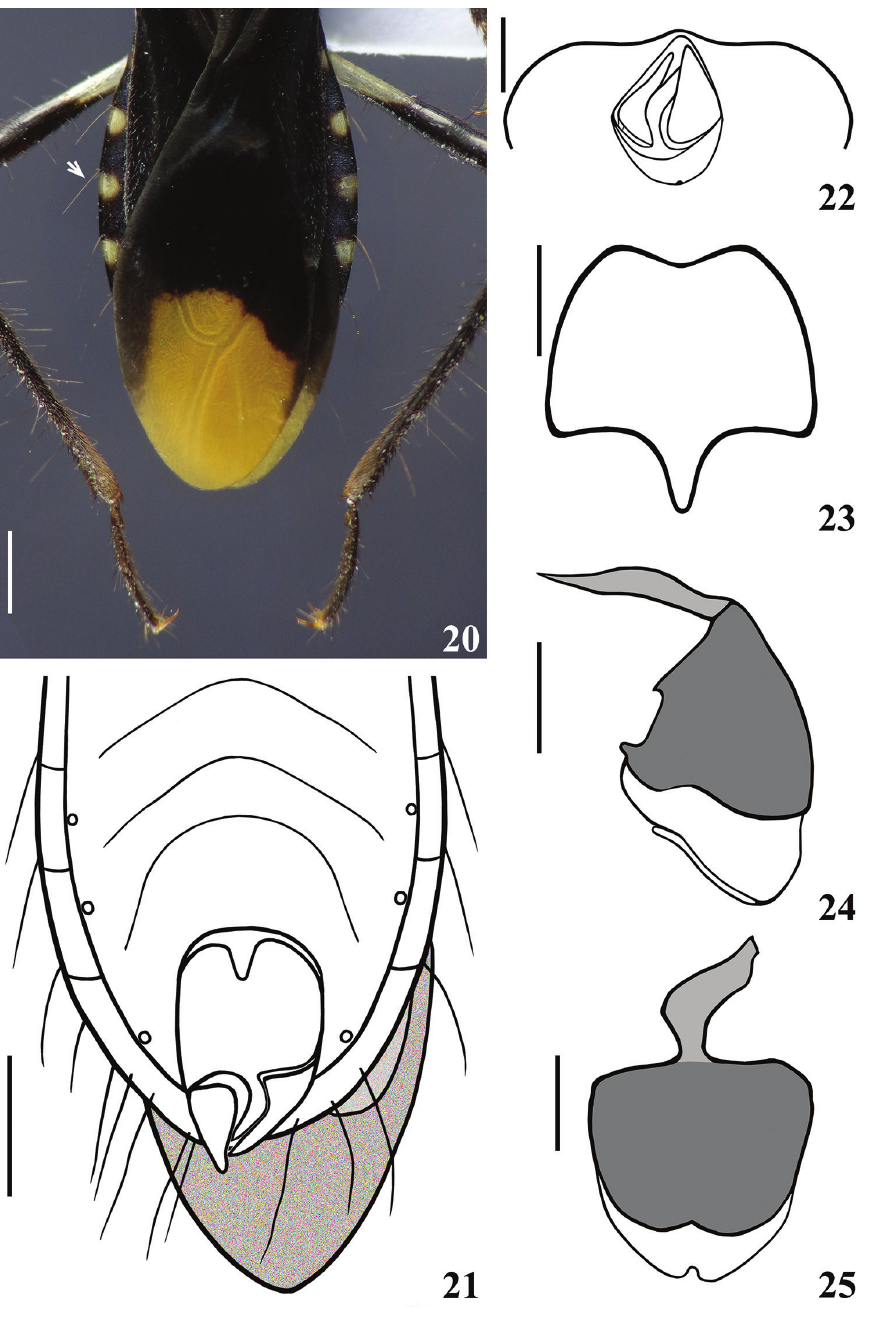
Figures 20–25. Zeraikia zeraikae sp. n., male holotype. 20 distal portion of hemelytra and connexivum, dorsal view (the arrow points to a single conspicuous long, stiff, darkened seta implanted just above pos- terolateral angle of a connexival segment) 21 distal portion of abdomen, ventral view 22 apical portion of abdomen, posterior view (hemelytra omitted) 23 sternite VIII, ventral view 24–25 pygophore without parameres 24 lateral view 25 ventral view. Scale bars: 1.0 mm ( 20–21 ); 0.5 mm ( 22–25